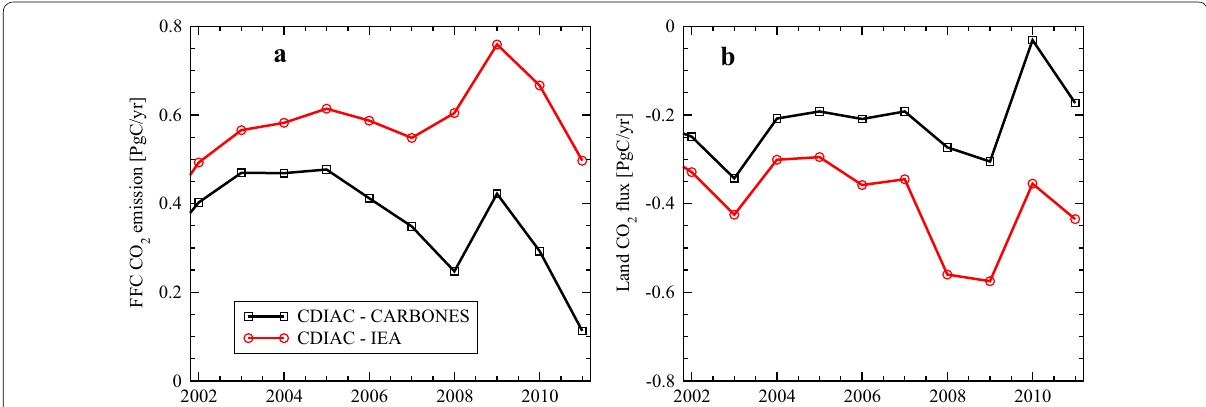
Fig. 3 Time series of differences in FFC CO 2 emission cases (CARBONES and IEA) relative to the CDIAC case ( a ), and the resulting differences in land CO 2 sinks estimated by 84-region inverse model ( b ) for East Asia ( black line : CDIAC–CARBONES; red line : CDIAC–IEA)